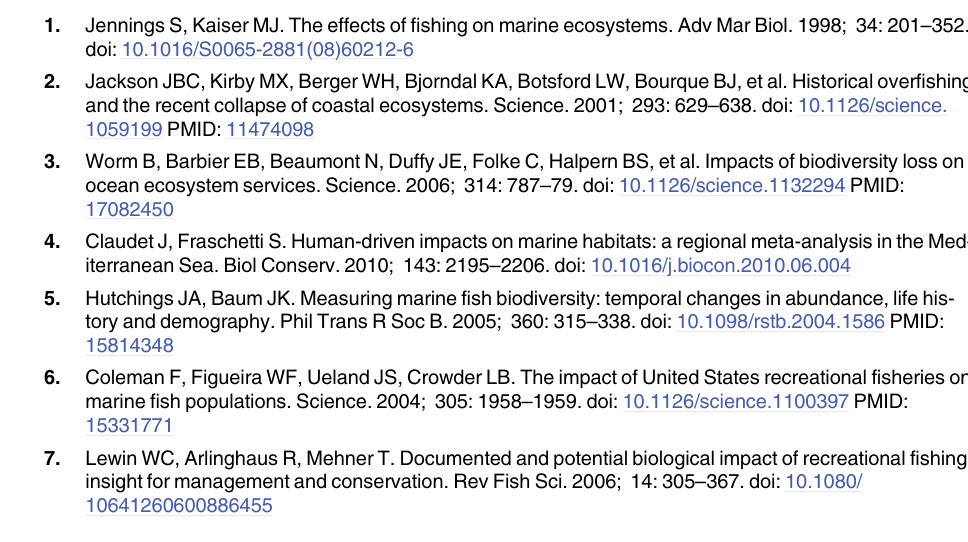
S3 Table. Results of SIMPER analyses. Fish taxa mostly contributing to the dissimilarity between years and levels of protection are shown. Only dissimilarity contributions > 5% are reported. S4 Table. Complete results of univariate Permanova analyses on square root transformed data. (cid:1) p < 0.05; (cid:1)(cid:1) p < 0.01; (cid:1)(cid:1)(cid:1) p <